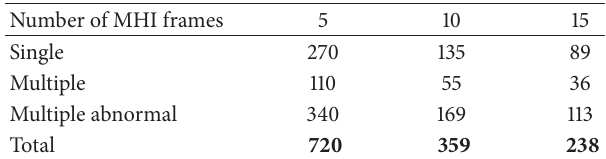
Table 2: Testing data